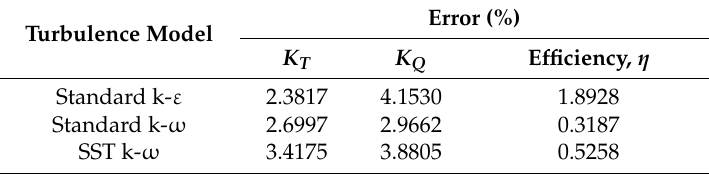
Table 5. Computational results with a different turbulence model for J = 0.628.